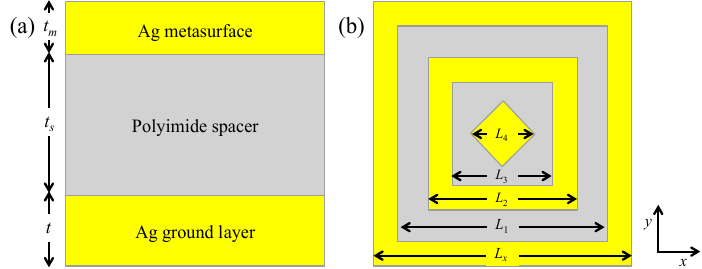
Figure 1. Panel ( a ): the cross section of the THz dual-band absorber where t m , t s and t are the Ag metasurface, polyimide spacer and Ag ground layer thicknesses, respectively. Panel ( b ): the metasurface plasmonic nanoantenna plane view.